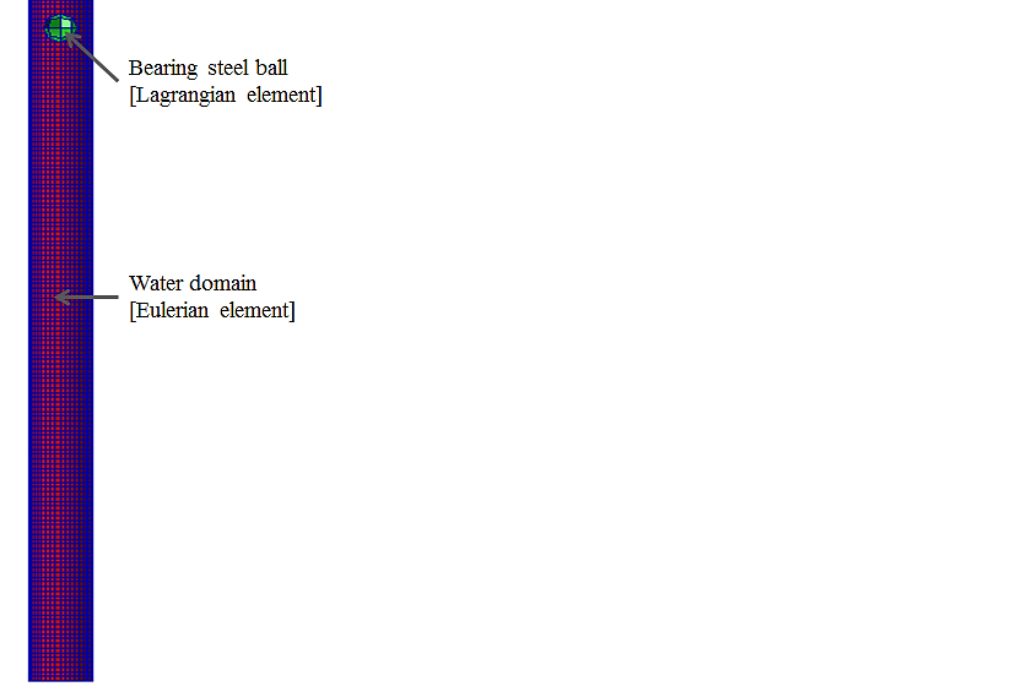
Figure 5. Numerical simulation model for underwater drop test of bearing steel sphere.